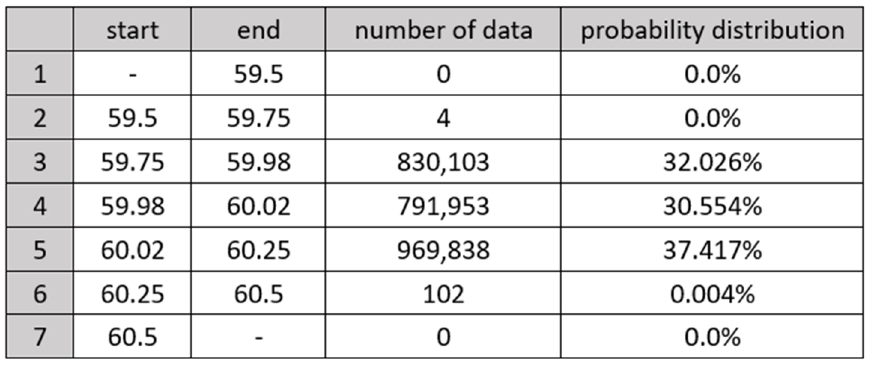
Figure A5. Frequency distribution of May 2020.